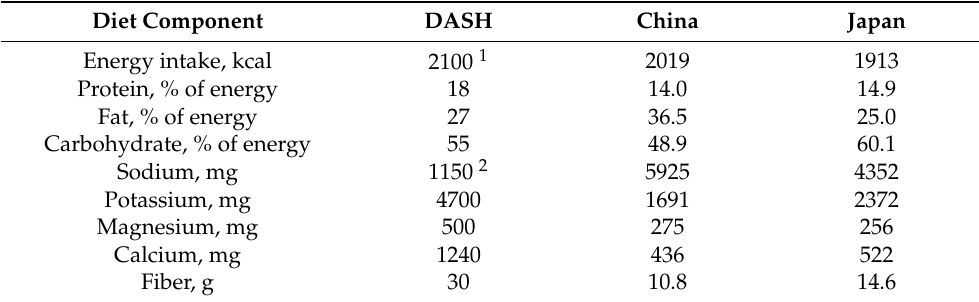
Table 1. Comparison between nutrient intakes in the Dietary Approaches to Stop Hypertension (DASH) diet and usual nutrient intakes in selected East Asian